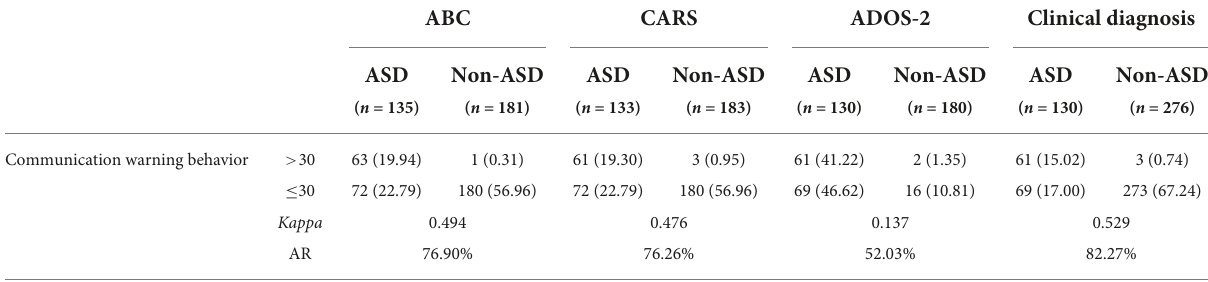
TABLE 3 Consistency between the communication warning behavior (cutoff value = 30) of CNBS-R2016 and ABC, CARS, ADOS-2, and clinical diagnosis for the classification of ASD. ABC CARS ADOS-2 Clinical diagnosis ASD Non-ASD ASD Non-ASD ASD Non-ASD ASD Non-ASD ( n = 135) ( n = 181) ( n = 276)